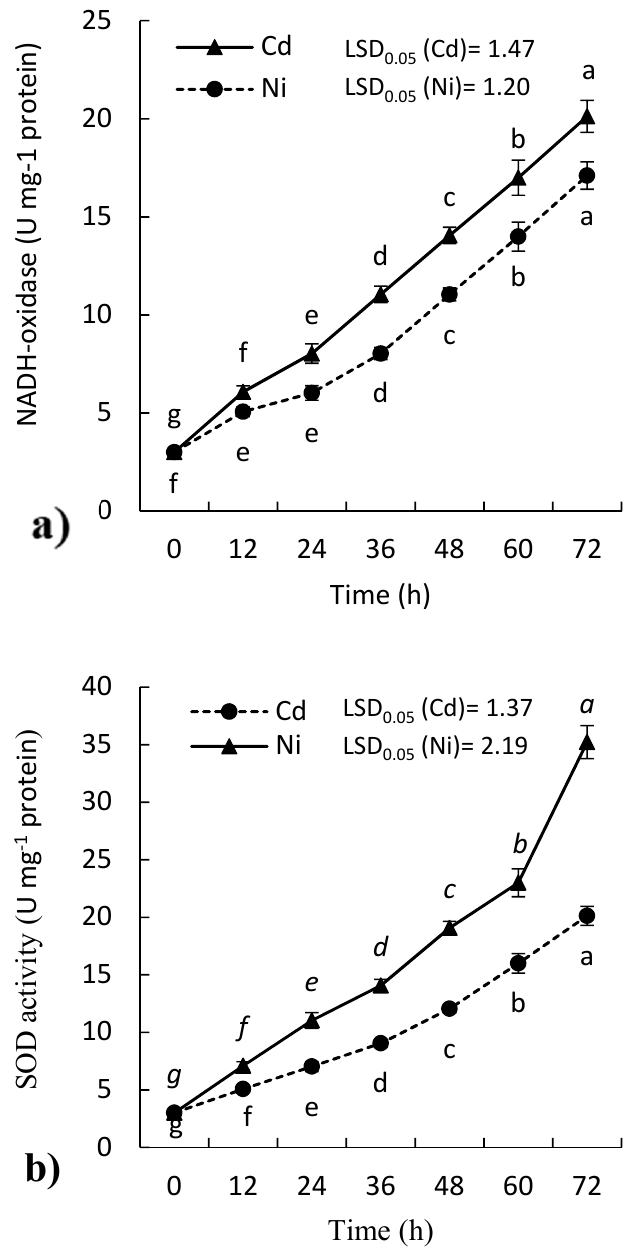
Figure 3. Effect of Cd and Ni on the activity of ( a ) NADH-oxidase and ( b ) superoxide dismutase (SOD) in the leaves of P. sativum with time. Different letters per each line mean a significant difference ( p ≤ 0.05). Values are average of means ( n = 6 ) and bars represent the standard error. LSD 0.05 is the least significant difference at the probability level of 0.05.